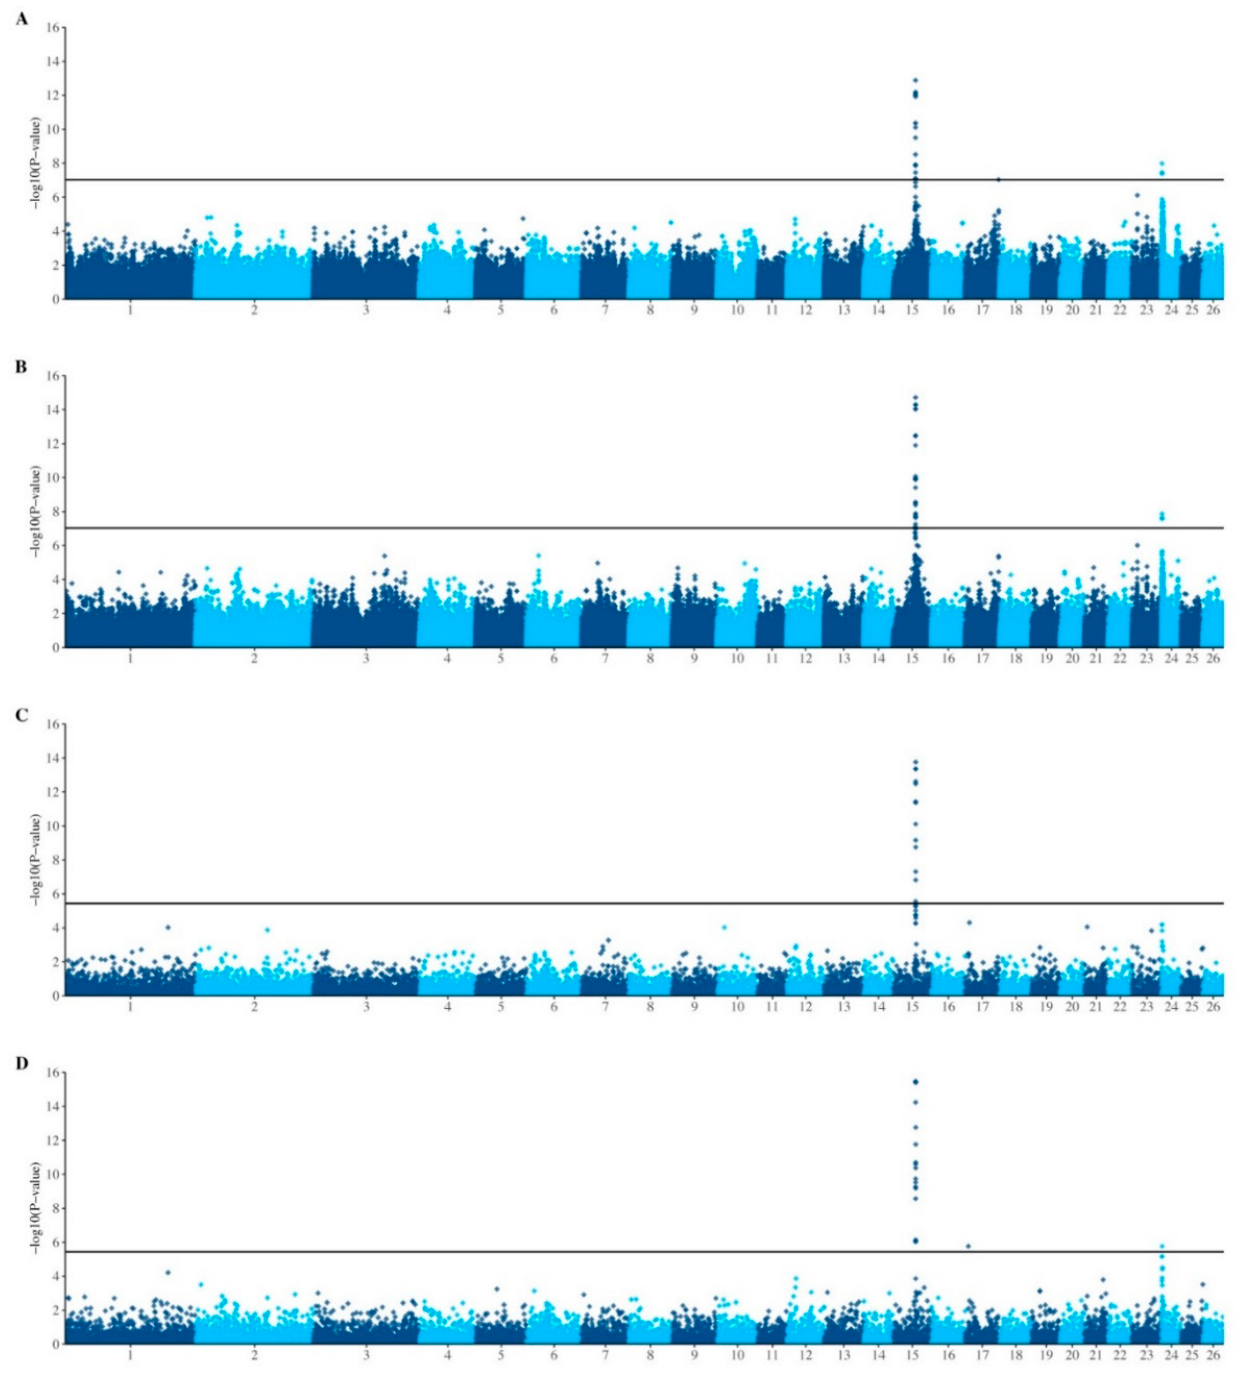
Figure 1. Manhattan plots of genome-wide association analysis for Facial Eczema in New Zealand sheep. Efficient Mixed- Model Association eXpedited (EMMAX) analyses using a kinship matrix ( A , C ) were conducted using log-transformed serum GGT levels at 21 days after a measured sporidesmin challenge (GGT21), with the contemporary group and the first two principal components fitted as covariates. Genotype association tests ( B , D ), fitting two principal components, were performed using residuals obtained from ASReml after fitting pedigree and the fixed effect of the contemporary group. Animals had either high-density (genotyped using either the Ovine Infinium ® HD SNP BeadChip or the Illumina OvineSNP50 BeadChip, and imputed to HD) ( A,B ) or low-density (Illumina OvineLD BeadChip) ( C,D ) genotypes. After Bonferonni correction, the threshold for genome-wide significance ( P < 0.05) was 1.04×10 − 7 (log-transformed = 6.98) and 3.39×10 − 6 (log-transformed = 5.47) for high-density and low-density analyses, respectively.